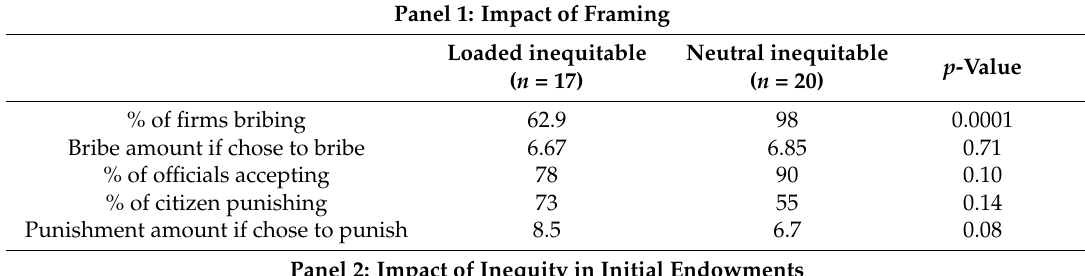
Table 3. Results of Wilcoxon ranksum tests for bribe, acceptance and punishment rates; average over ten rounds by